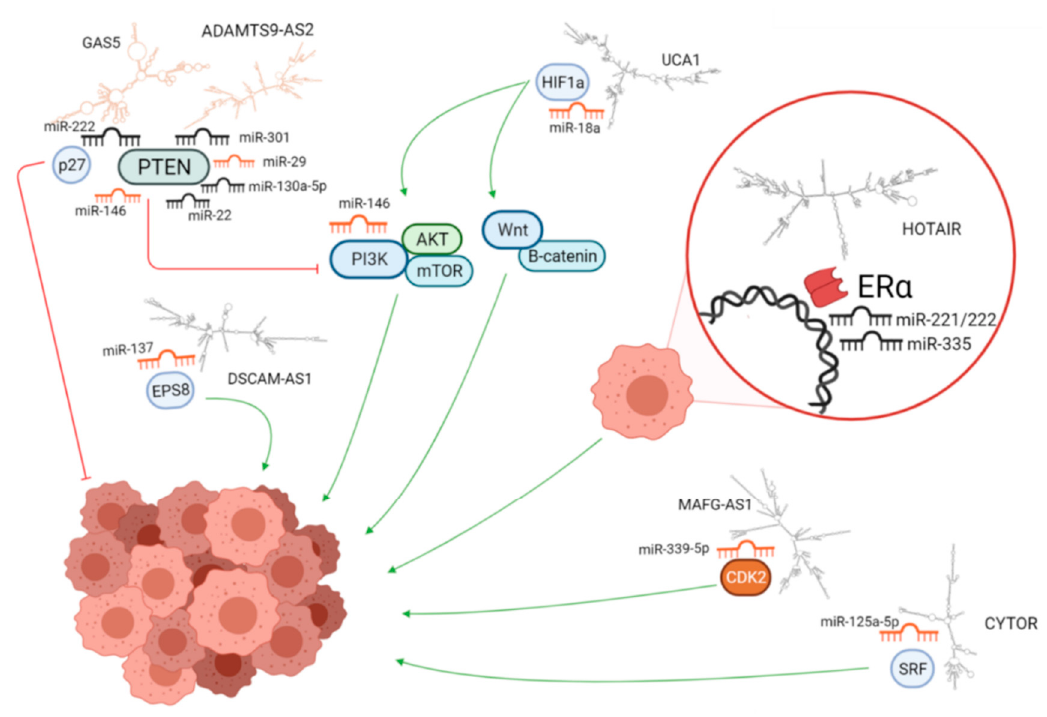
Figure 4. miRNAs, lncRNAs, and target mRNA differentially expressed in resistant breast cancer cells lines. Upregulated miRNAs and lncRNAs are in black, while those downregulated are in orange. Structures of lncRNAs were predicted using the RNAfold tool in the ViennaRNA Package 2.0 and drawn using MFE plain structure drawing. The figure does not contain all regulatory molecules found in this study. The molecules are not to scale.